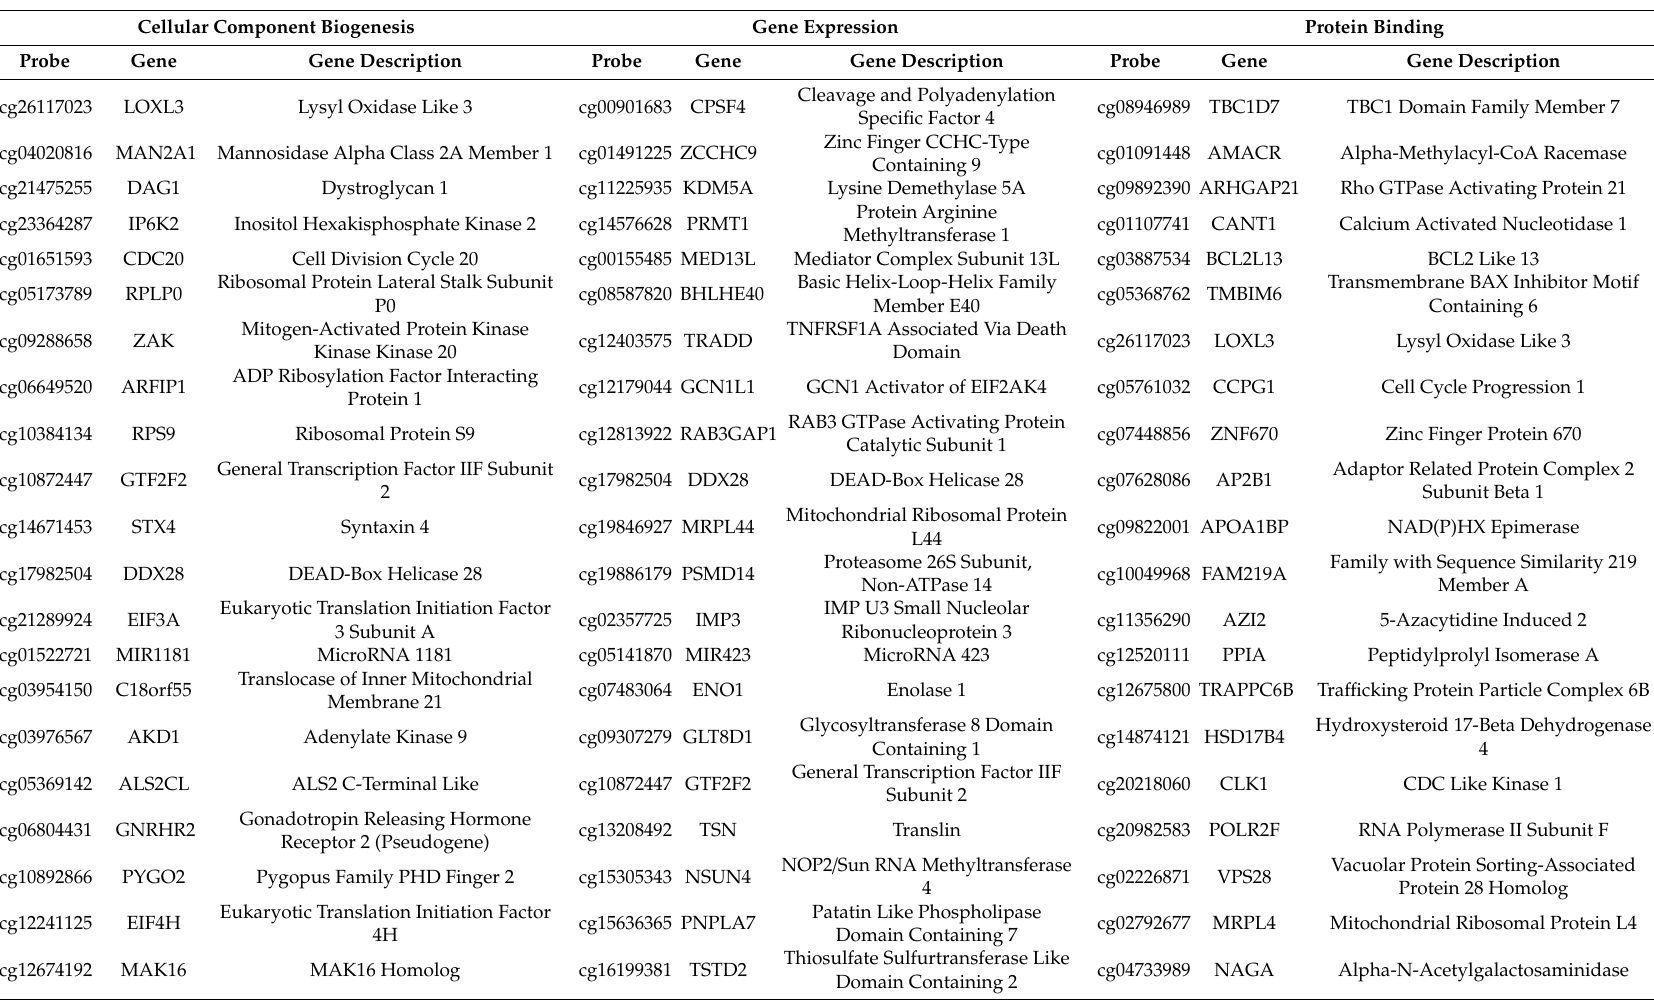
Table 6. Protein binding, cellular component organization, and gene expression methylation signatures’ probes, associated genes, and gene